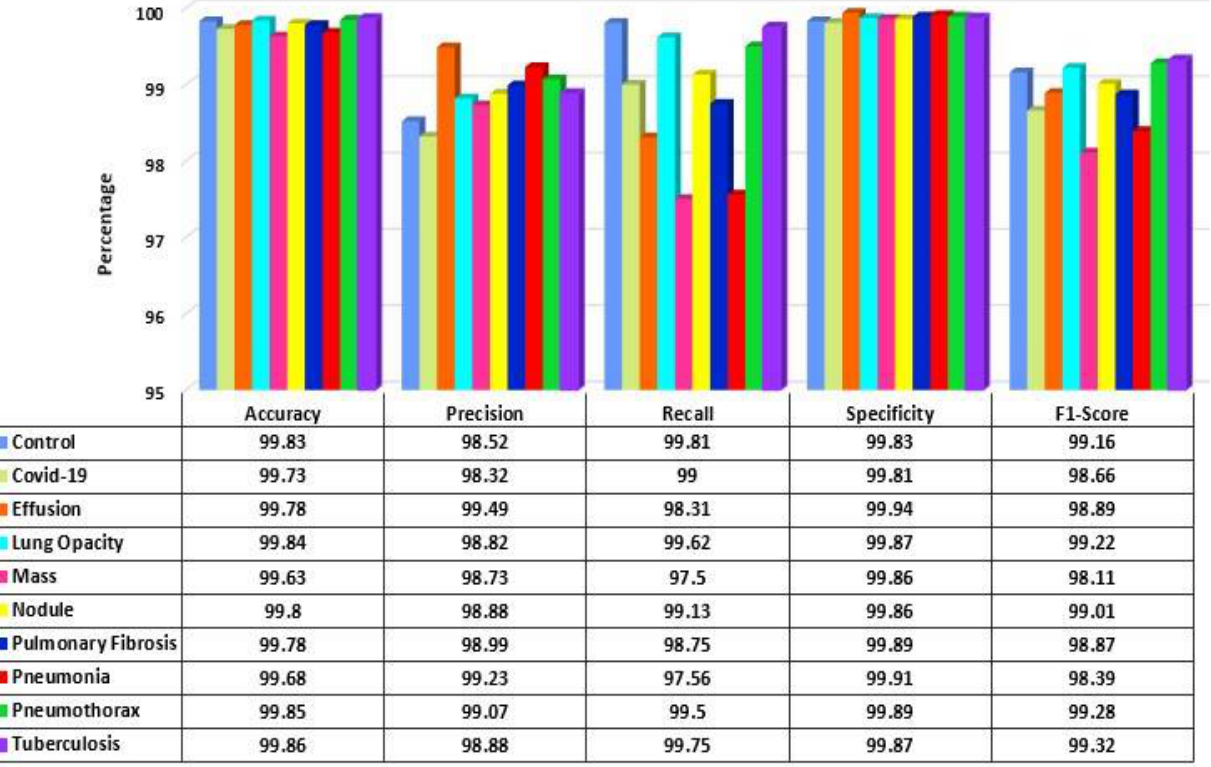
Figure 13. Performance score of LungNet22 network.